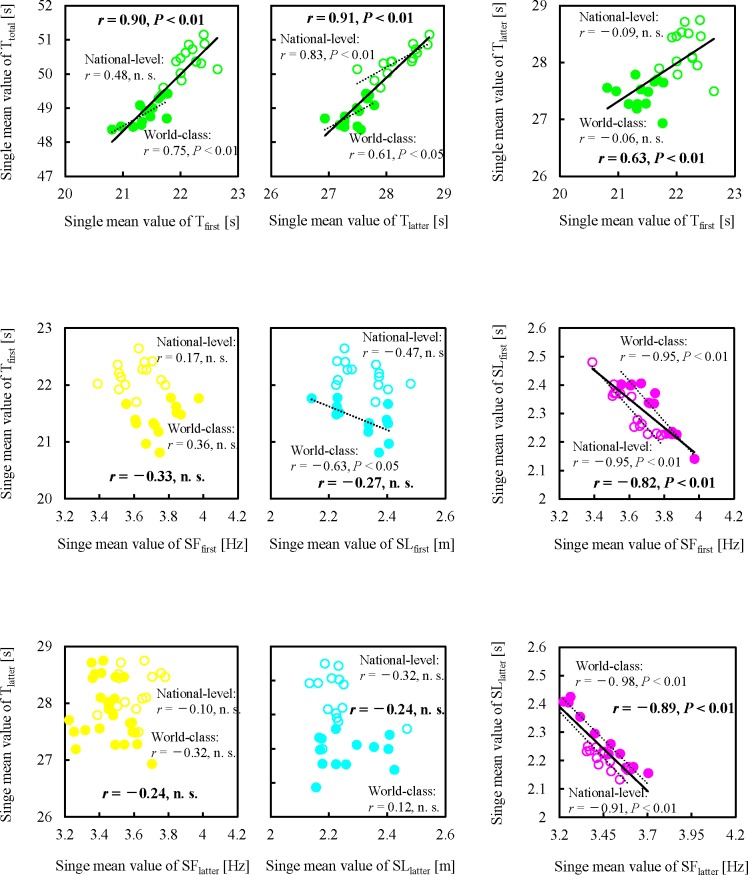
Scatter plots for single mean values of finish time, split time and step characteristics in inter-athlete relationships.The single mean value in all parameters were calculated from those in all trials (world-class hurdlers: 16.5 ± 3.9 races; national-level hurdlers: 19.8 ± 6.0 races). Filled circles denote data of world-class hurdlers and open circles denote data of national-level hurdlers. Solid lines indicate the regression lines for all hurdlers. Dot lines indicate the regression lines for world-class and national-level hurdlers separately. Single mean value of Ttotal, single mean value of finish time; single mean value of Tfirst, single mean value of split time during the first half of the race; single mean value of Tlatter, single mean value of split time during the latter half of the race; single mean value of SFfirst, single mean value of mean step frequency during the first half of the race; single mean value of SLfirst, single mean value of mean step length during the first half of the race; single mean value of SFlatter, single mean value of mean step frequency during the latter half of the race; single mean value of SLlatter, single mean value of mean step length during the latter half of the race; n. s., not significant.